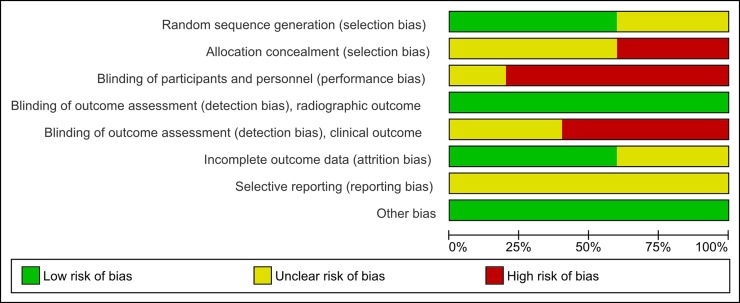
Risk of bias graph. Percentage of each risk of bias item across included studies.